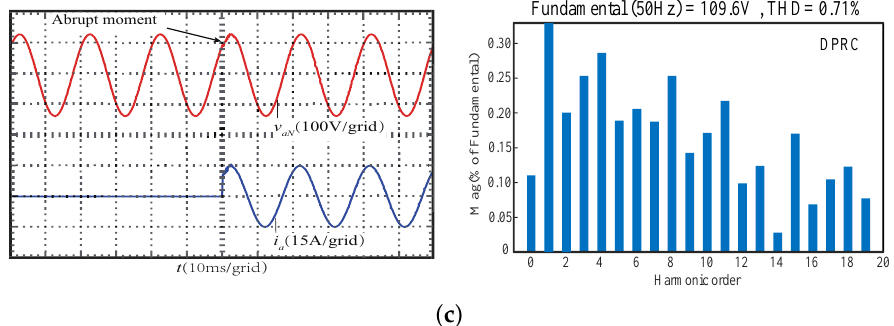
Figure 15. Voltage, current and voltage waveform distortion under linear load. ( a ) PI controller ( b ) RC controller ( c ) DPRC controller.